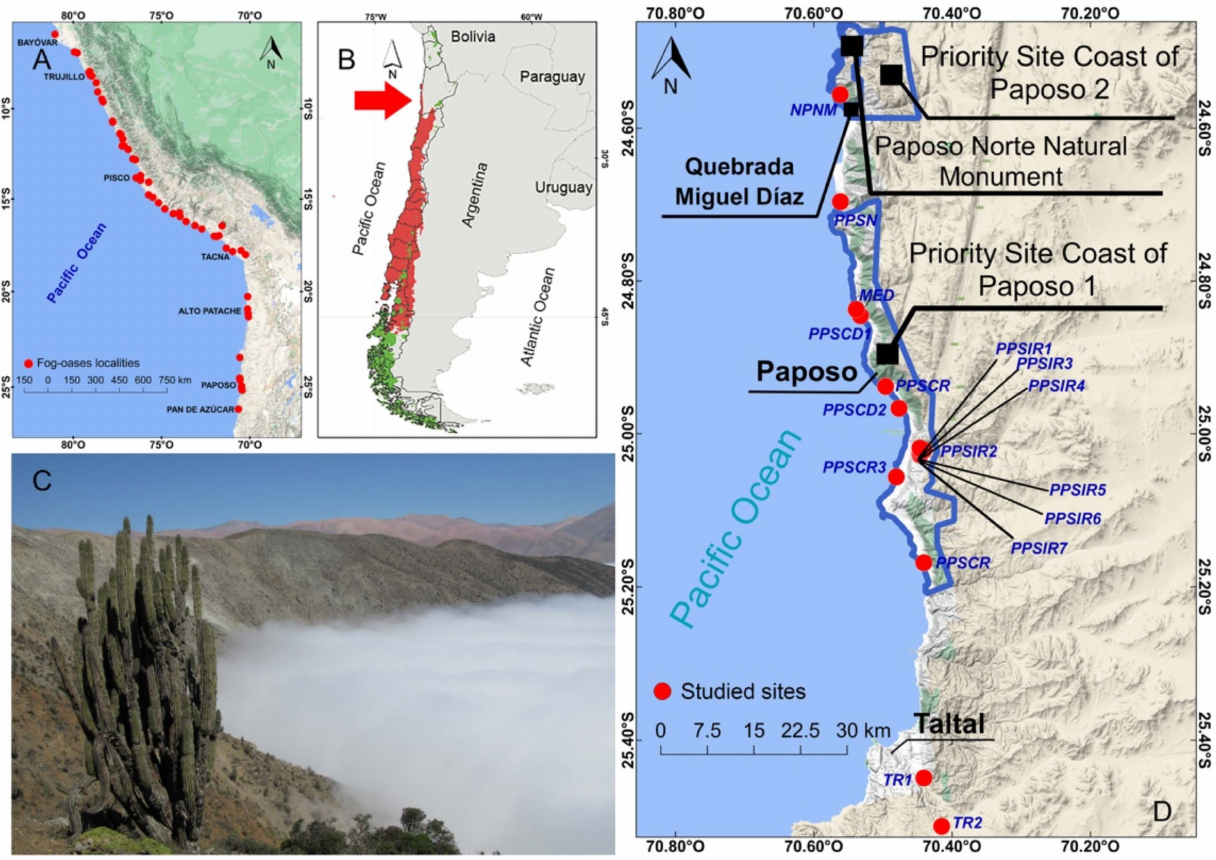
Figure 1. Regional context of the study area: ( A ) fog-oases along the Peruvian and Chilean arid coast (red dots). ( B ) The Mediterranean Chilean biodiversity hotspot (marked in red); Paposo-Taltal section highlighted by red arrow. ( C ) Caman- chaca over the coastal cliffs of the study site. ( D ) Location of the studied sites in the coastal section North of Paposo to South of Taltal, and limits of Paposo Norte Natural Monument and Priority Site Coast of Paposo, 1 and 2 (Antofagasta Region,